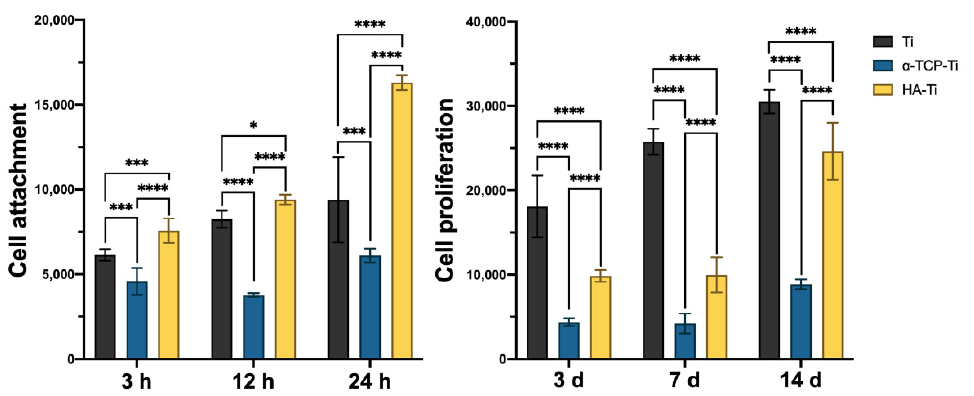
Figure 10. Cell attachment and proliferation of rat bone marrow mesenchymal stem cells on Ti, α - TCP-Ti, and HA-Ti discs ( n = 3); * p < 0.05, *** p < 0.001, **** p <